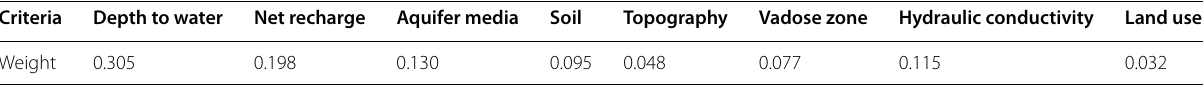
on single parameters sensitivity analysis. Based on the